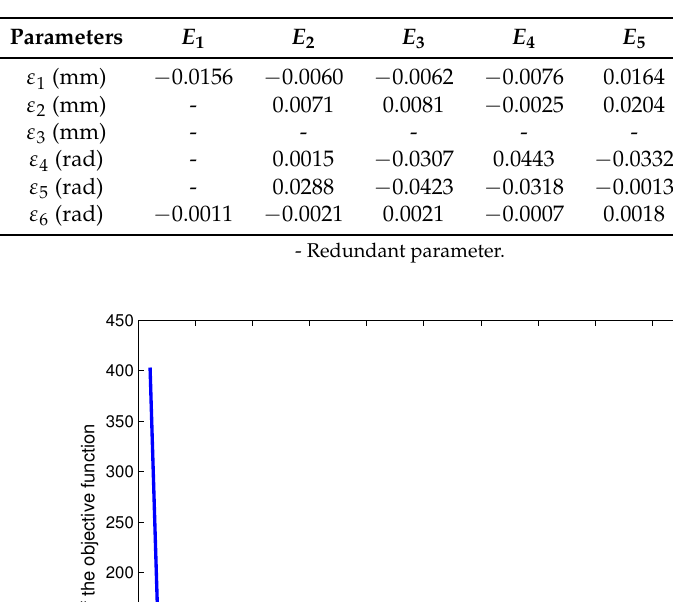
Table 2. Generalized geometric error parameters calibrated.